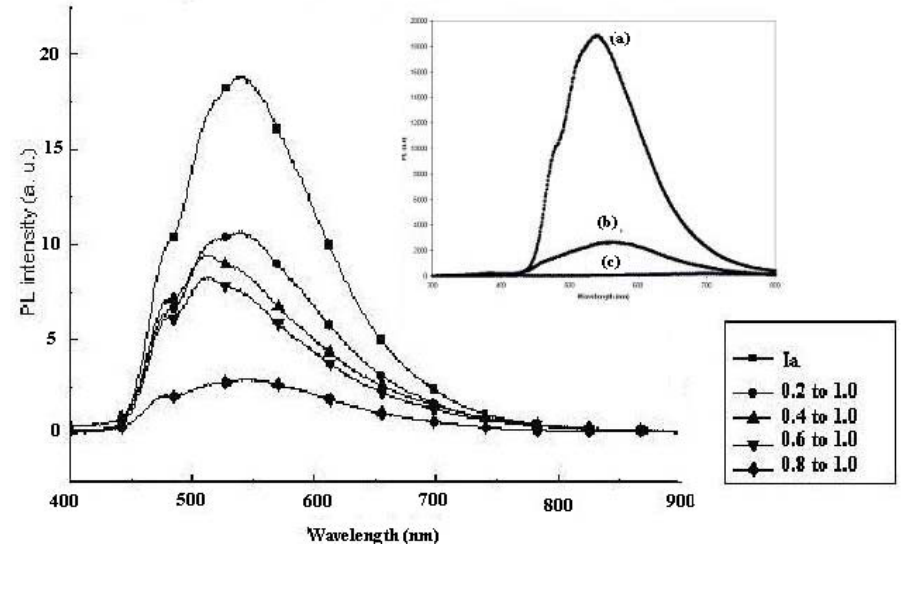
Figure 9. Photoluminescence study of CdS: Ia nanocomposites at different mass compositions (w/w); Insert: PL emission of (a) pure Ia ; (b) pure IIa ; (c) pure synthesized